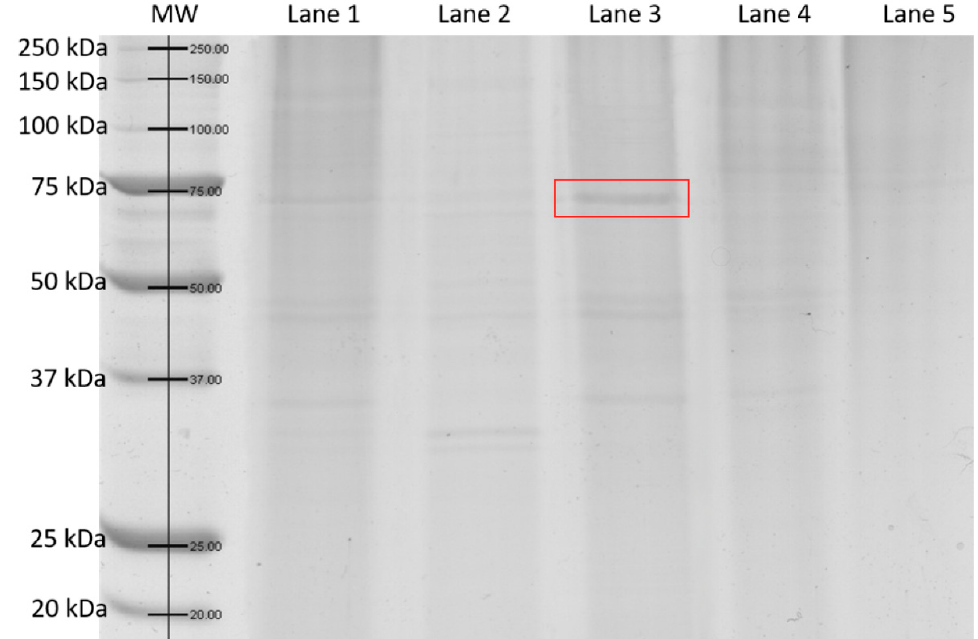
Figure 9. SDS-PAGE after salting out of laccase K. bupleuri ; MW: molecular weight marker; Lane 1: crude post-culture supernatant; Lane 2: 40% saturation; Lane 3: 60% saturation; Lane 4: 80% saturation; Lane 5: supernatant after salting out with 80% saturation of ammonium sulphate. The laccase produced by K. bupleuri may have a mass of about 70–75 kDa (band at the lane 3 indicated using a red box)—the appearance of this band correlated with the highest specific activity of G3 laccase.